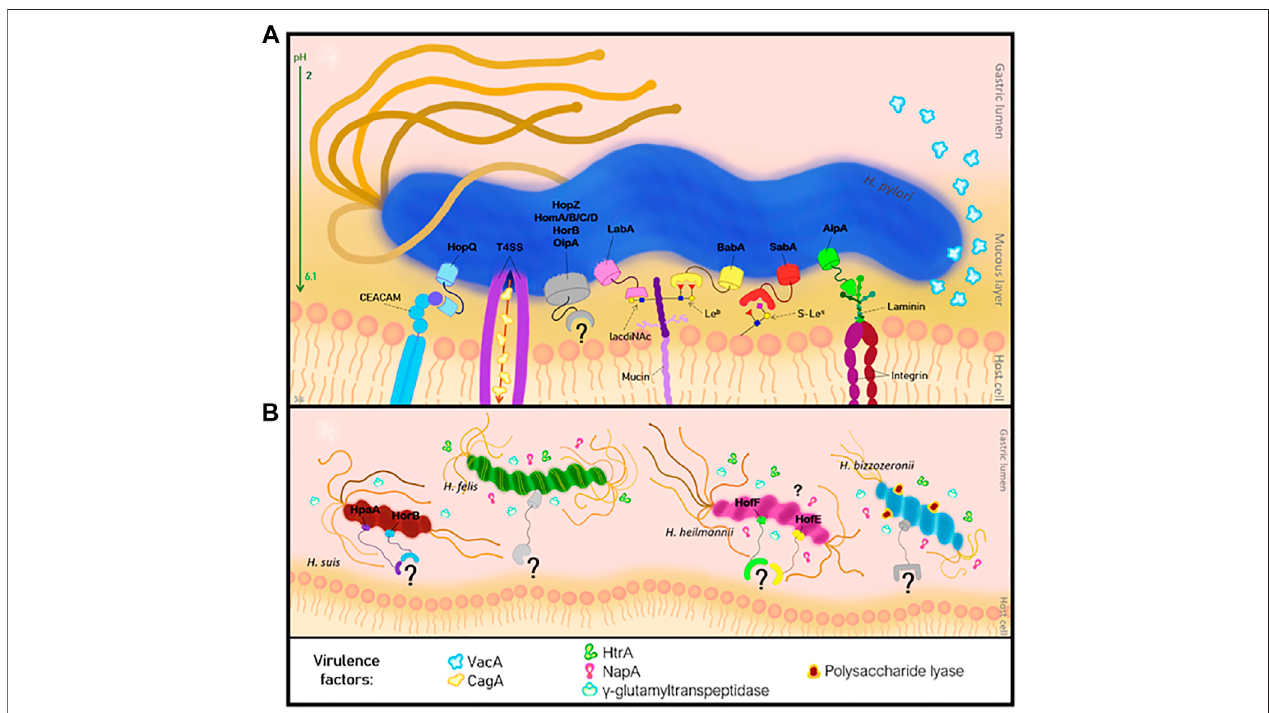
FIGURE2| Pathogenesisof Helicobacter infectionofthehumangastricmucosa. (A) Interaction of H.pylori adhesinswiththehostcellreceptors,and thevirulence factors. (B) NHPH adhesins and virulence factors involved in the adhesion mechanism.